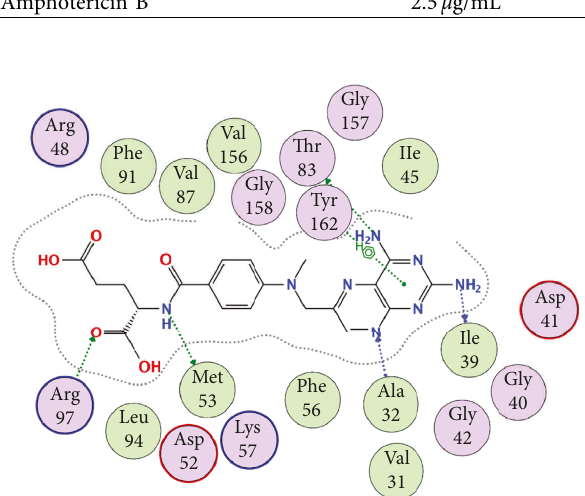
Figure 2: 2-D interaction plots of methotrexate into the active site of homology modeled Lm